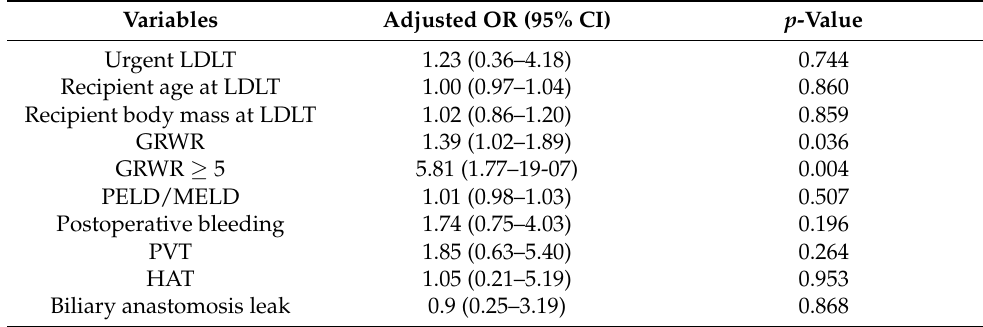
Table 7. Risk factors for recipient death in multivariate analysis.